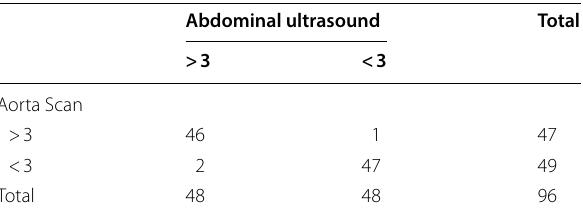
Table 4 Results of Aorta Scan compared to abdominal ultrasound excluding patients with